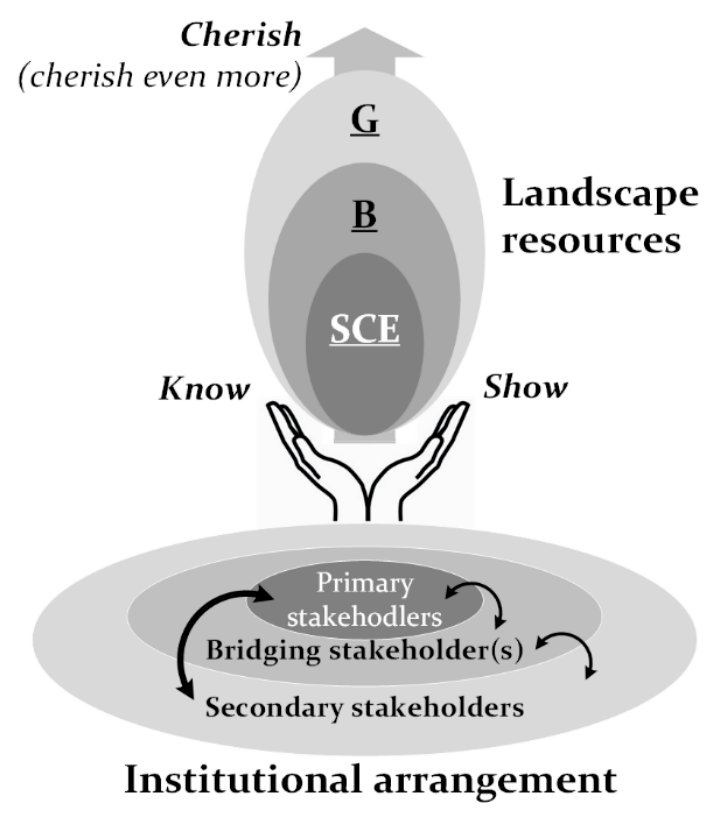
Figure 4. Landscape resources and institutional arrangement for integrated landscape management within a socio–cultural–biophysical system.